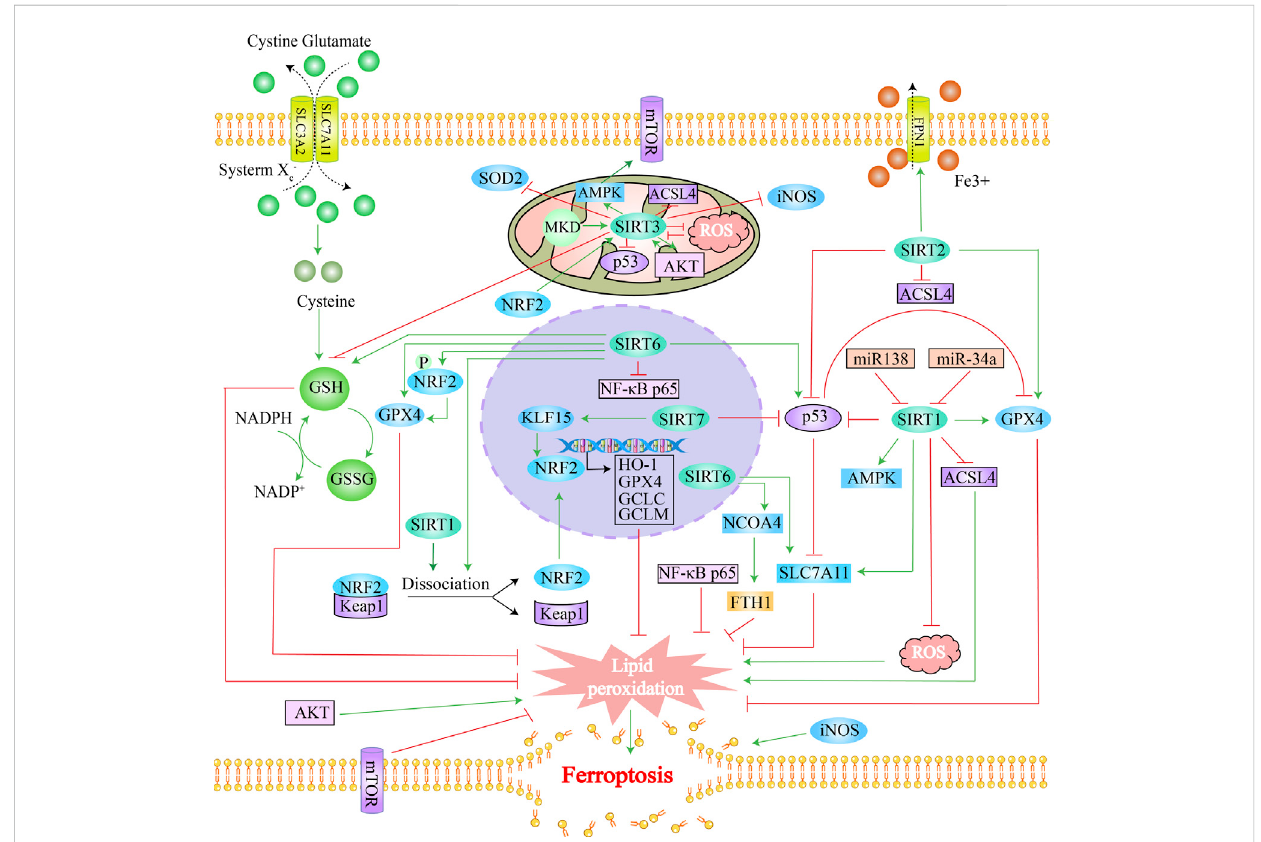
FIGURE 2 Overview of sirtuins and ferroptosis: Green lines represent promotion effects and red lines represent inhibition effects in the fi gure. Weconstructed sirtuins family pathways related to ferroptosis using Adobe illustrator software according to the gene pathways described in the text. Schematic diagram illustrating the distribution of sirtuins family members in the cell, their regulatory mechanisms, as well as functions. Sirtuins regulate ferroptosis by mediating lipid peroxides, ROS levels as well as iron content through different molecular